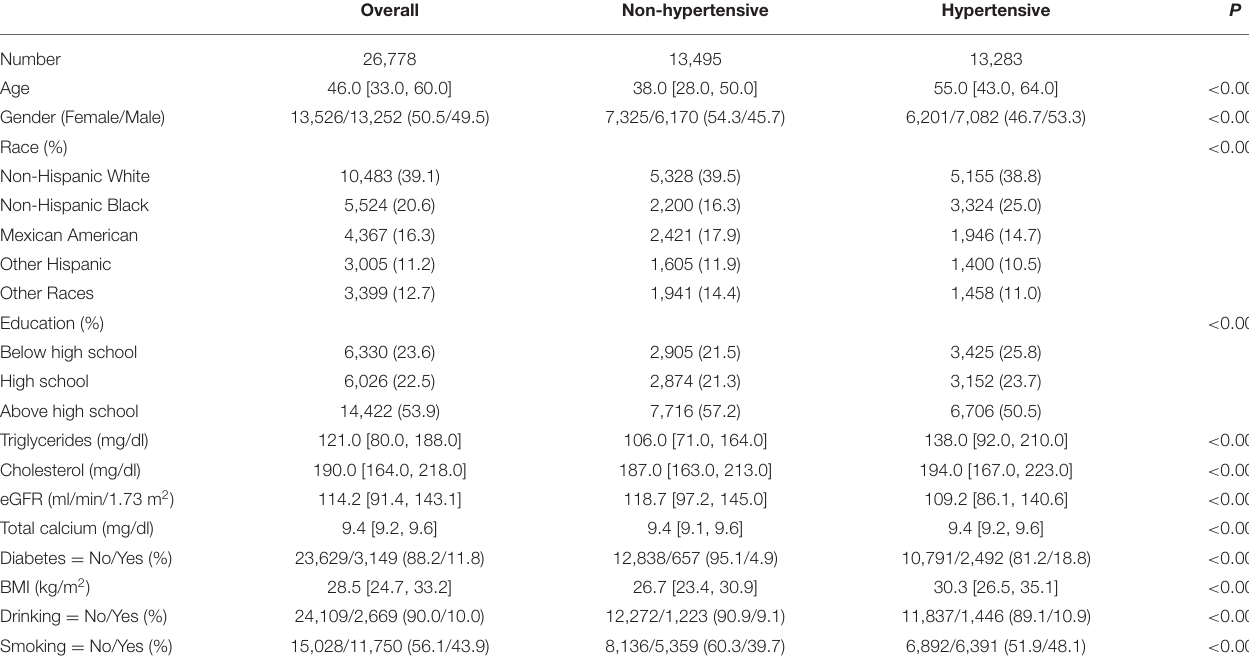
TABLE 1 | Baseline characteristics of study population.